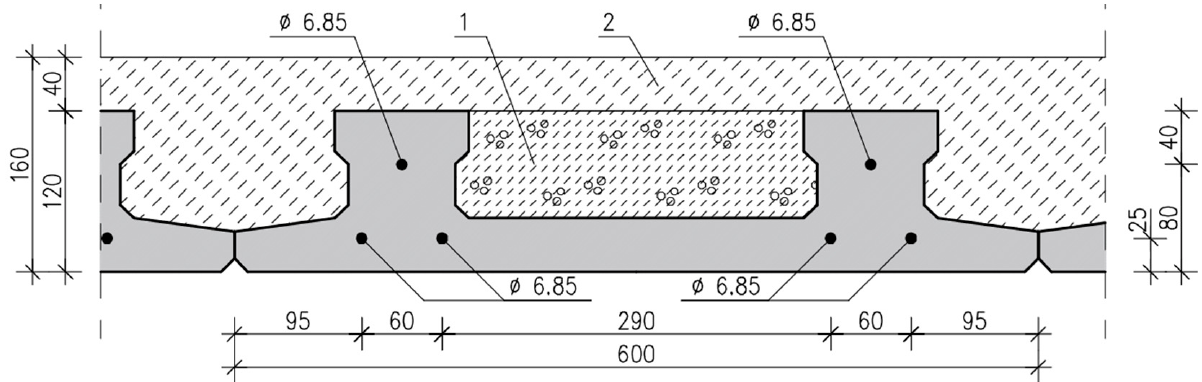
Figure 7. Cross-section of the slab with RP panels: 1—lightweight concrete and 2—concrete topping.